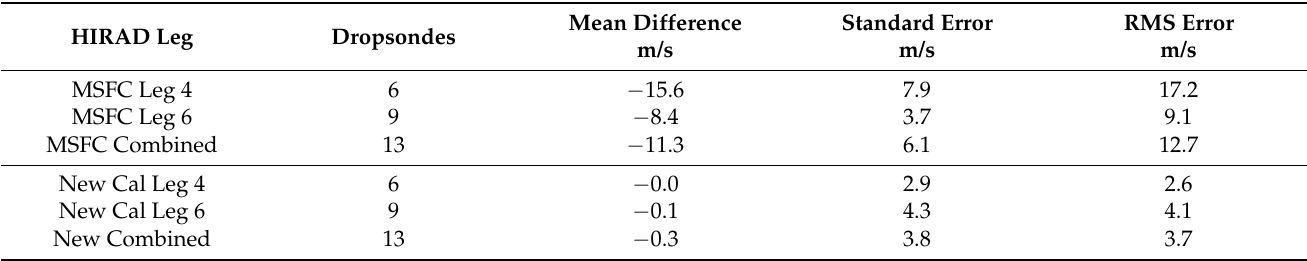
Table 2. HIRAD difference statistics with dropwindsondes (Dropsonde-HIRAD) where two son- des